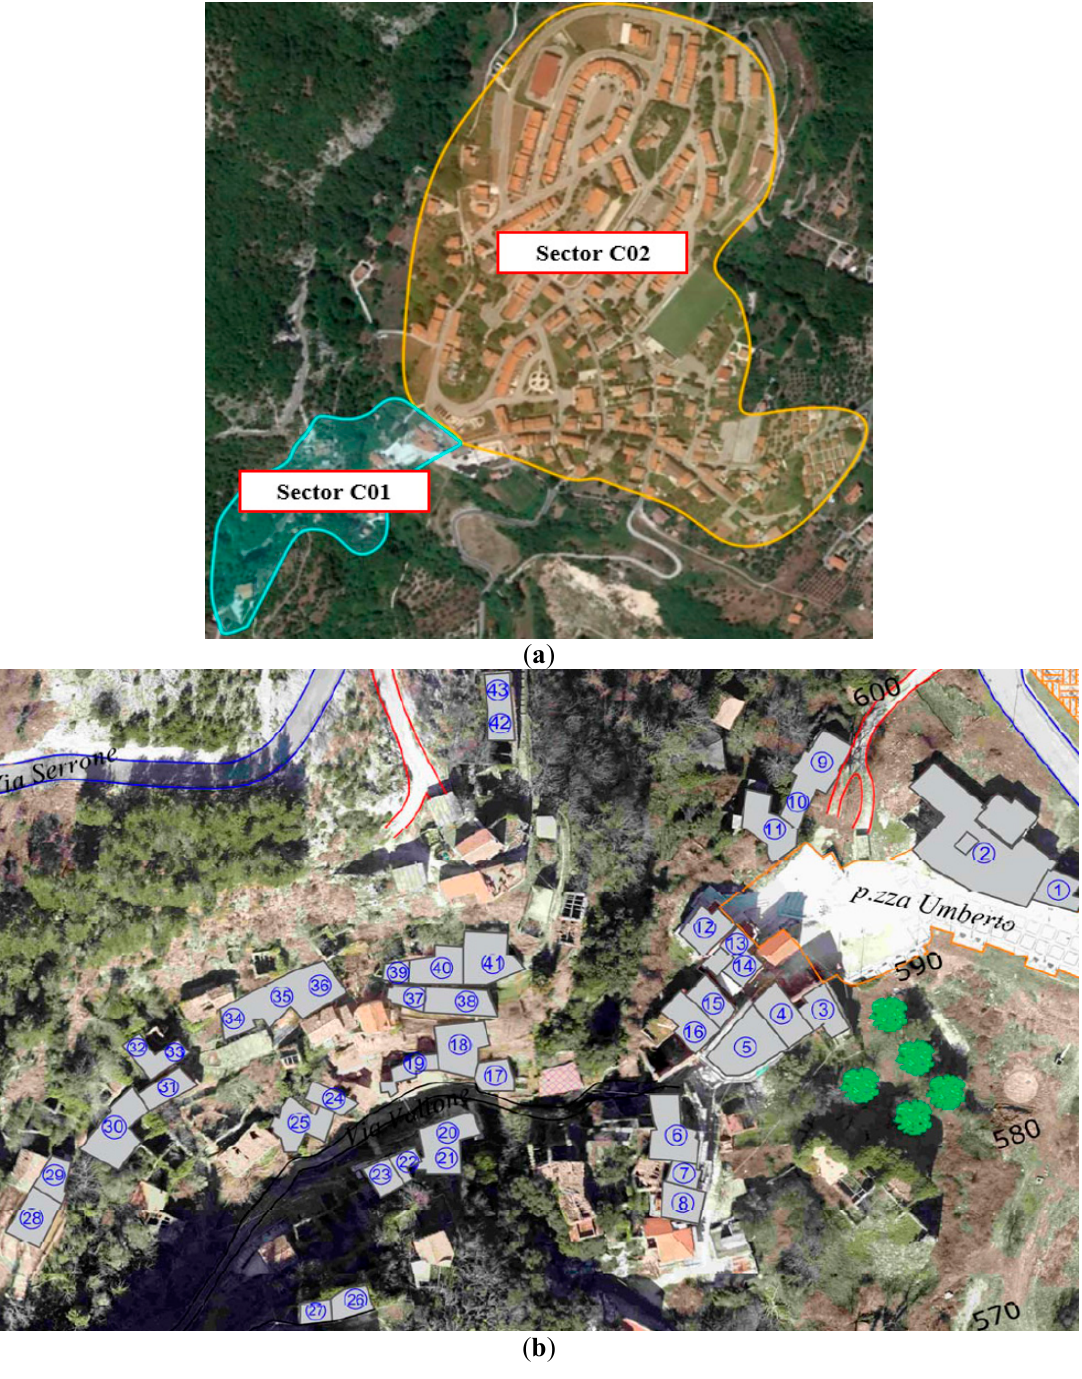
Figure 5. The study area: ( a ) urban sectors; ( b ) building inventory within the C01 sector.